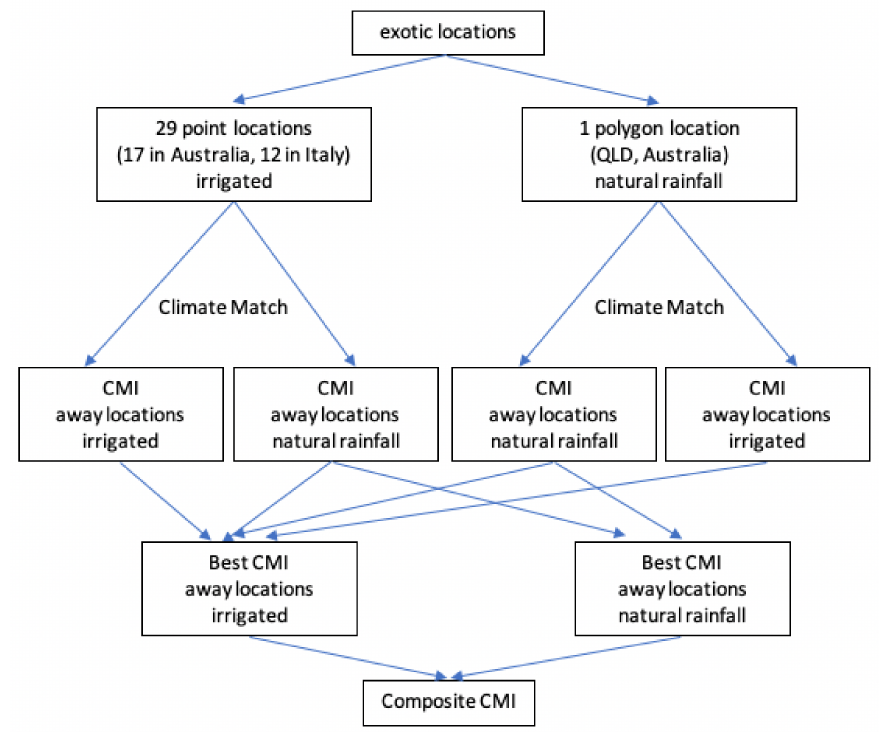
Figure A2. Schematic diagram of methodology for “Reverse” Climate Match (Regional)